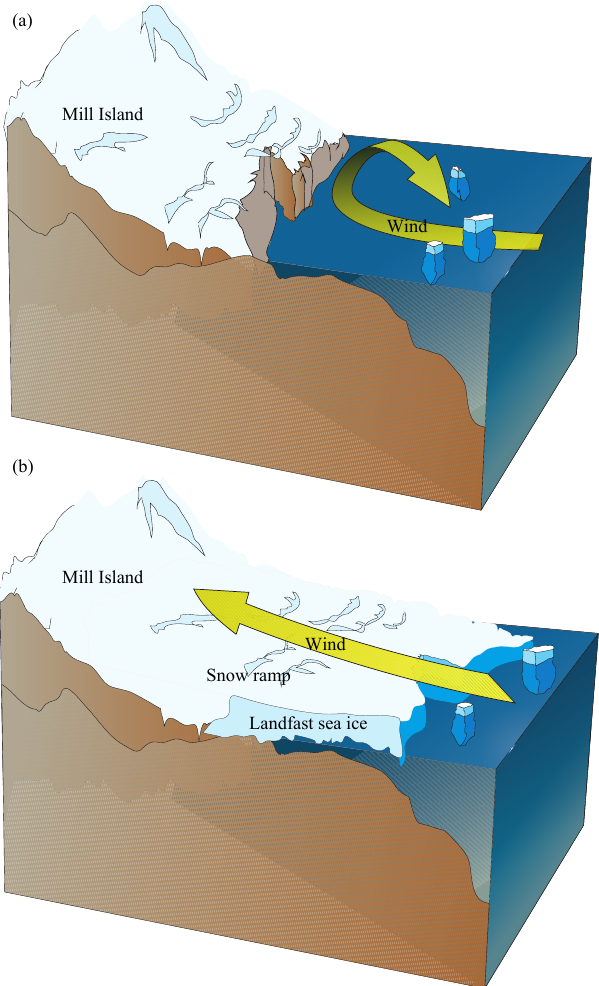
Figure 12. Schematic diagram of a hypothetical sea salt transport mechanism at Mill Island, including formation of a snow ramp. (a) No landfast sea-ice case: large sea salt particles cannot reach the Mill Island summit. (b) Landfast sea-ice case: large sea salt par- ticles can now reach the Mill Island summit.